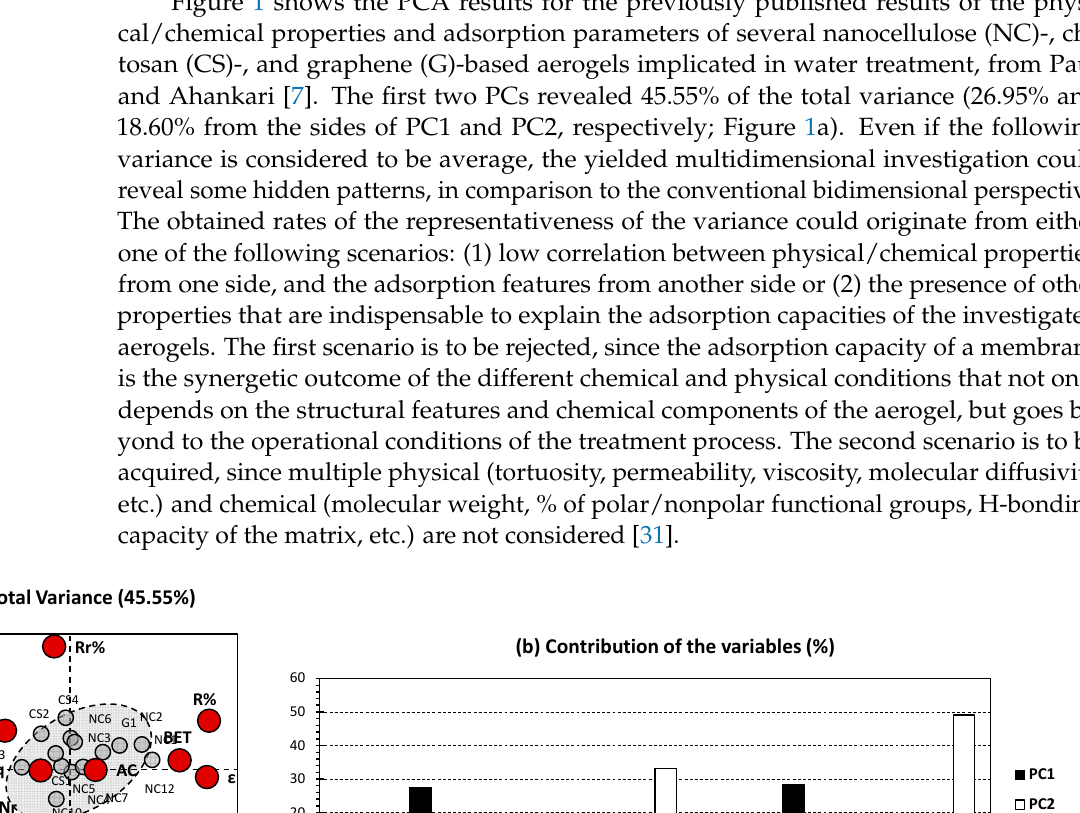
PC. The trends indicate an average representativeness of PC1, for R% and Nr as adsorption features; the latter are more likely to be influenced by porosity ( ε ) and BET surface area,